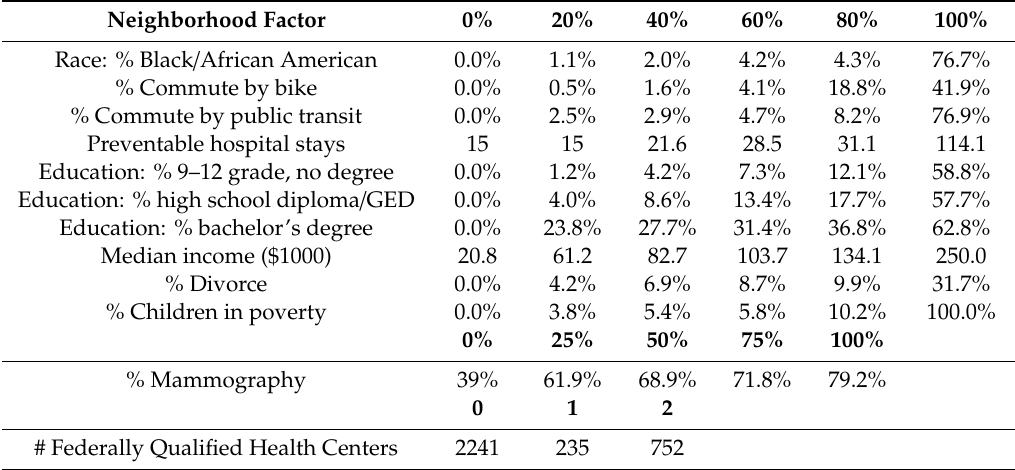
Table A1. Summary of break points for neighborhood factors quantile groupings.